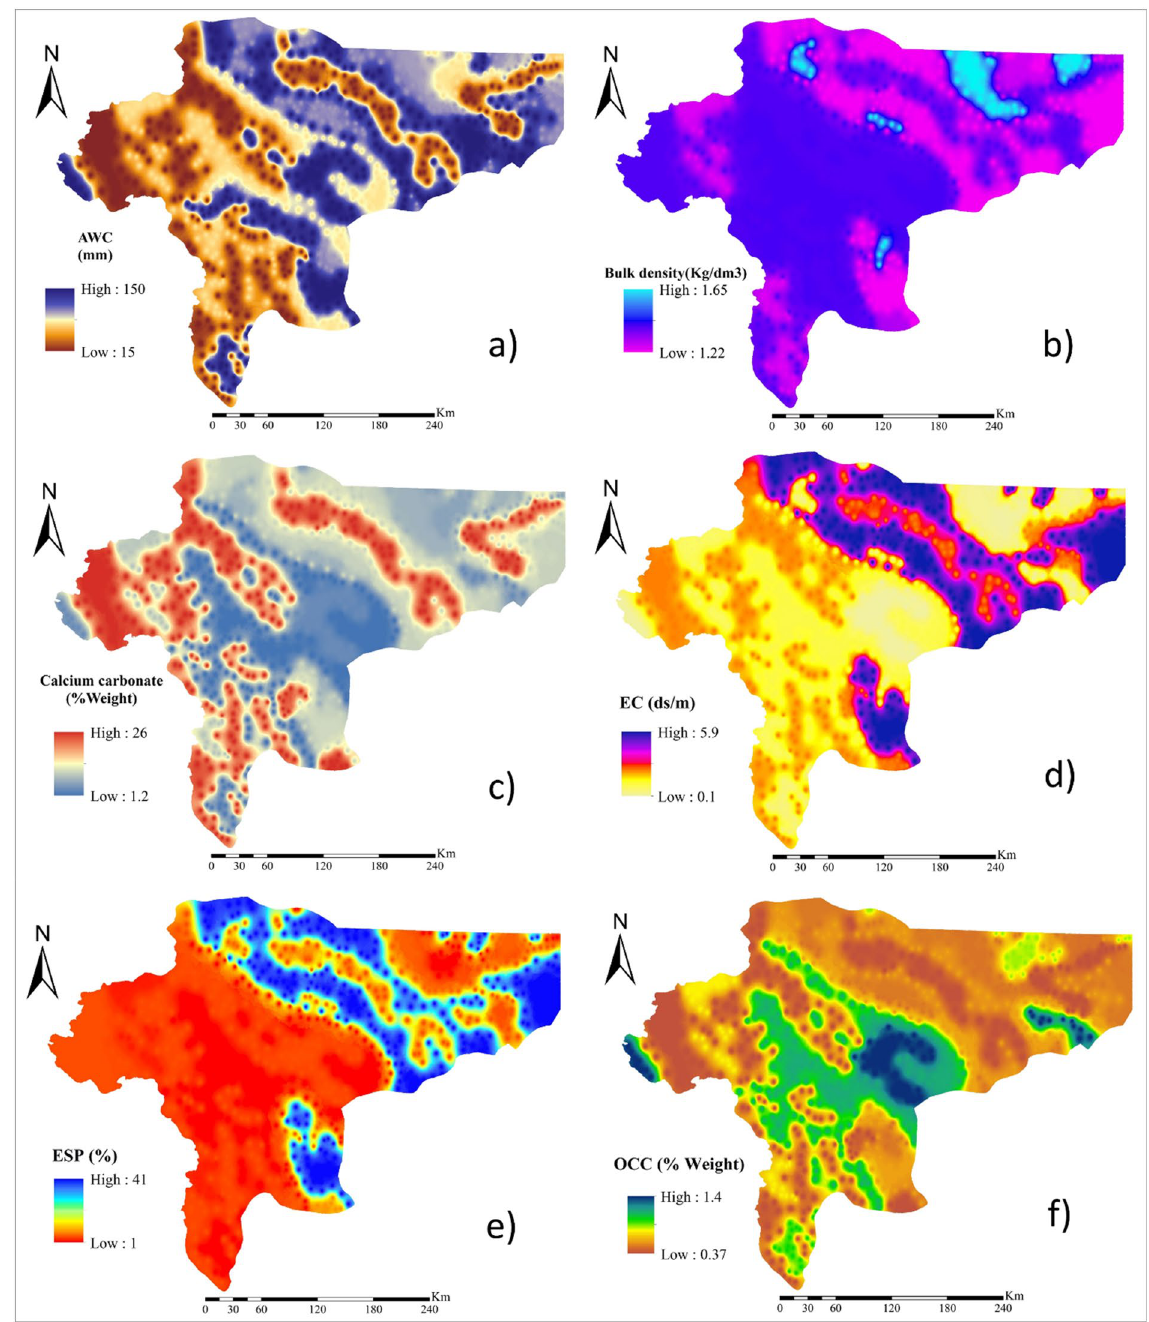
Figure 8. Spatial maps of soil characteristics: (a) AWC; (b) bulk density; (c) calcium carbonate percentage; (d) EC; (e) ESP, and; (f) OCC. All these factors were mapped spatially in ArcGIS 10.4.1 (https ://www.esri.com/ en-us/about /about -esri/overv